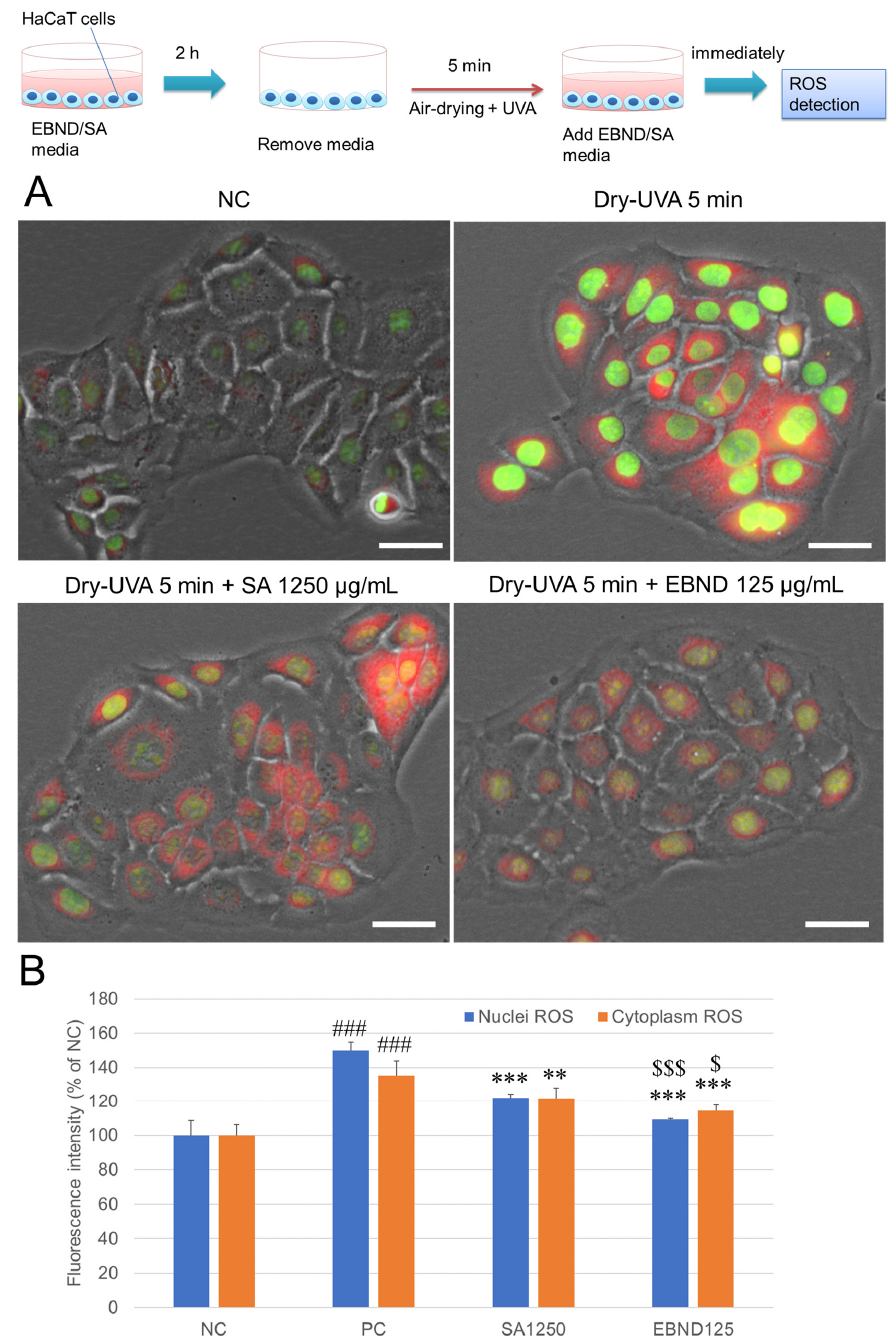
Figure 4. Effects of EBND and SA on air-drying- and UVA-caused intracellular ROS production in HaCaT keratinocytes. The top illustration represents the experimental procedures. ( A ) Typical fluorescence images of HaCaT cells displayed that 5 min air-dried